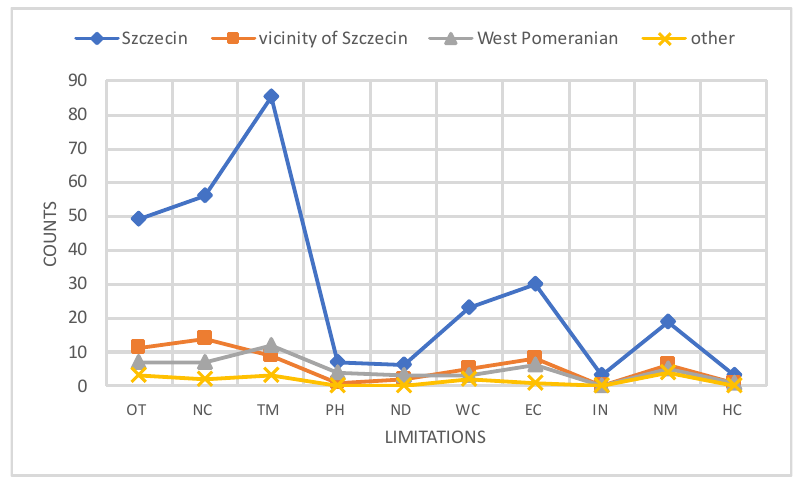
Figure 33. A graph of interaction between the limitations of the accessibility of tram transport and place of residence.